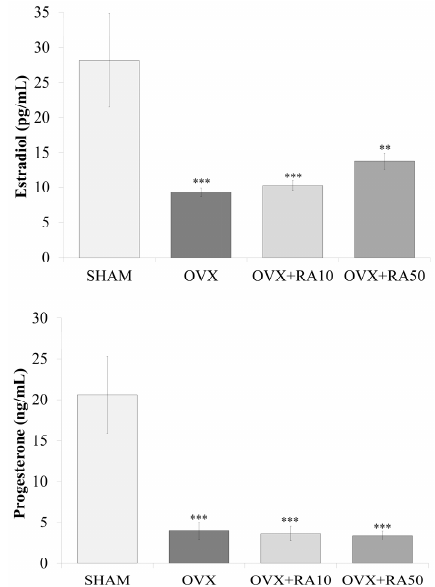
Figure 2. Effect of rosmarinic acid on the serum concentration of estradiol and progesterone in ovariectomized rats. Rosmarinic acid at doses of 10 mg/kg (OVX + RA10) and 50 mg/kg (OVX + RA50) was administered orally to ovariectomized rats, once daily for 28 days. SHAM: sham-operated control rats; OVX: ovariectomized control rats. Results are presented as the mean ± SEM. One-way ANOVA followed by Fisher’s LSD test were used for evaluation of the significance of the results. ** p < 0.01, *** p < 0.001: significantly different from the SHAM control rats.